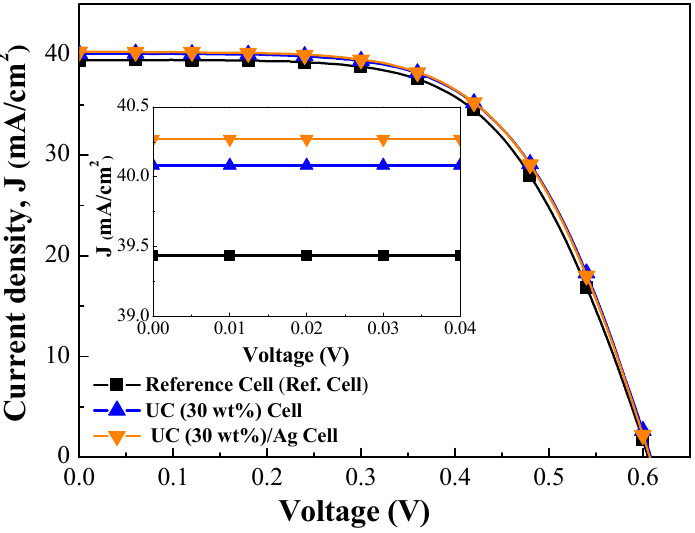
Figure 12. Photovoltaic J-V of reference cell, UC cell (30 wt%), and UC (30 wt%)/Ag cell.